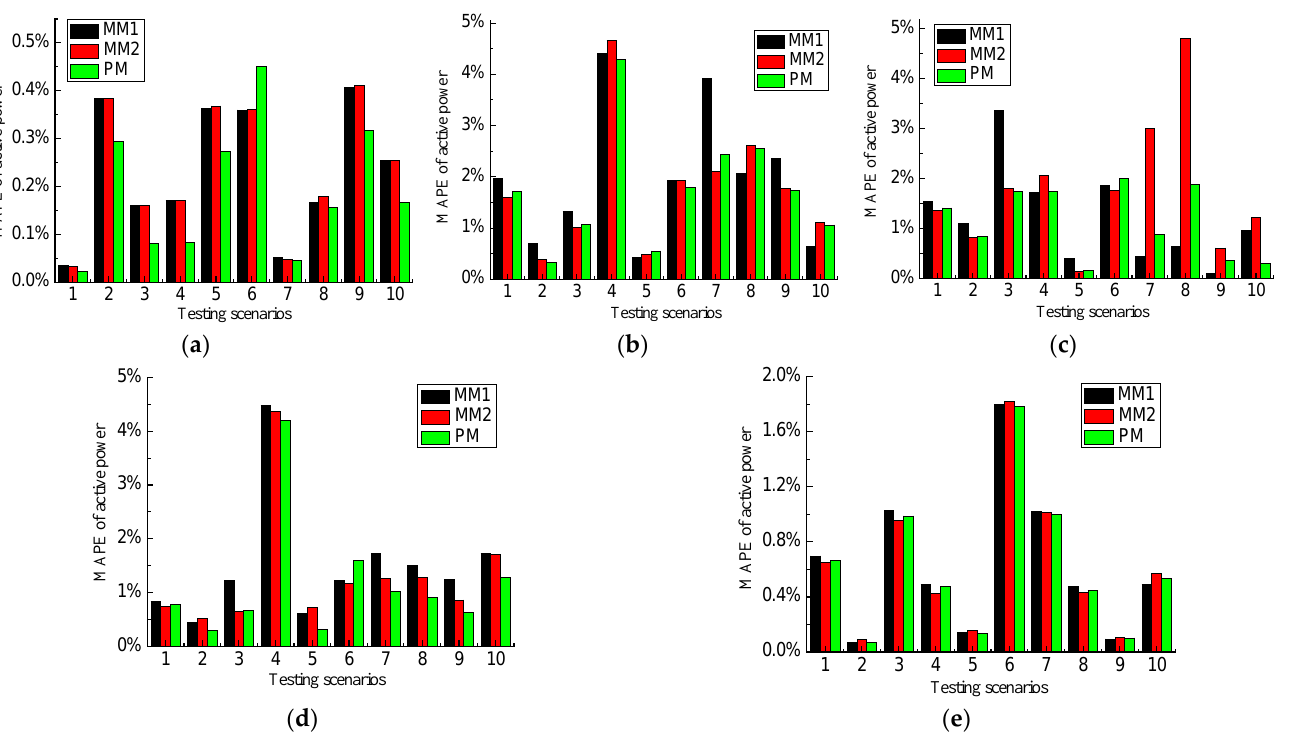
Figure 5. Active power response error of three equivalent models. ( a ) Pre-fault phase. ( b ) Early fault phase. ( c ) Quasi-steady-state phase during the fault. ( d ) Early fault recovery phase. ( e ) Quasi-steady- state phase during the fault recovery.